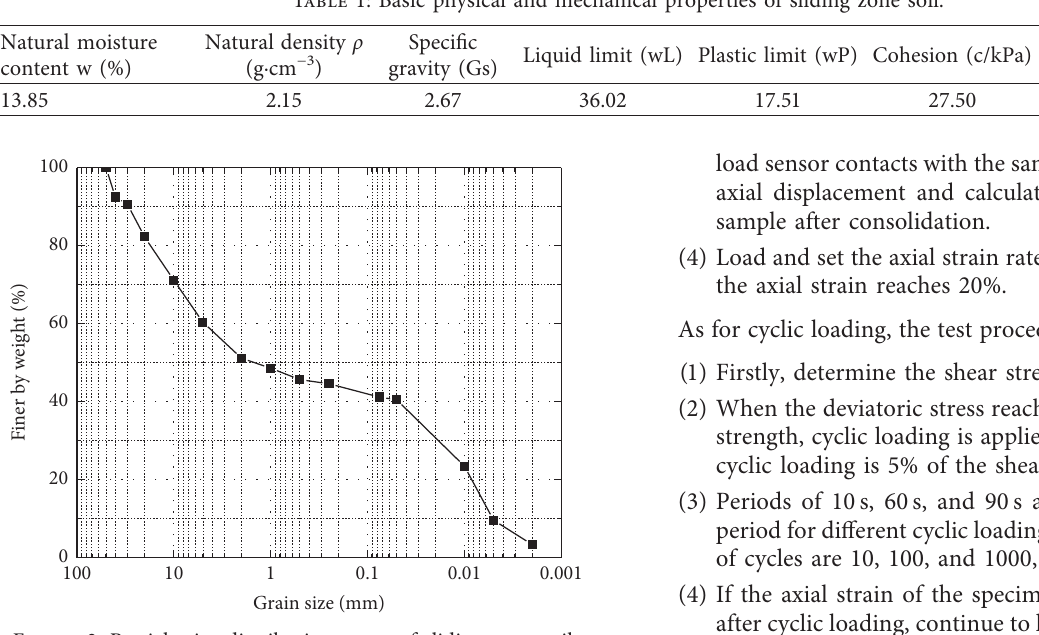
Figure 2: Particle size distribution curve of sliding zone